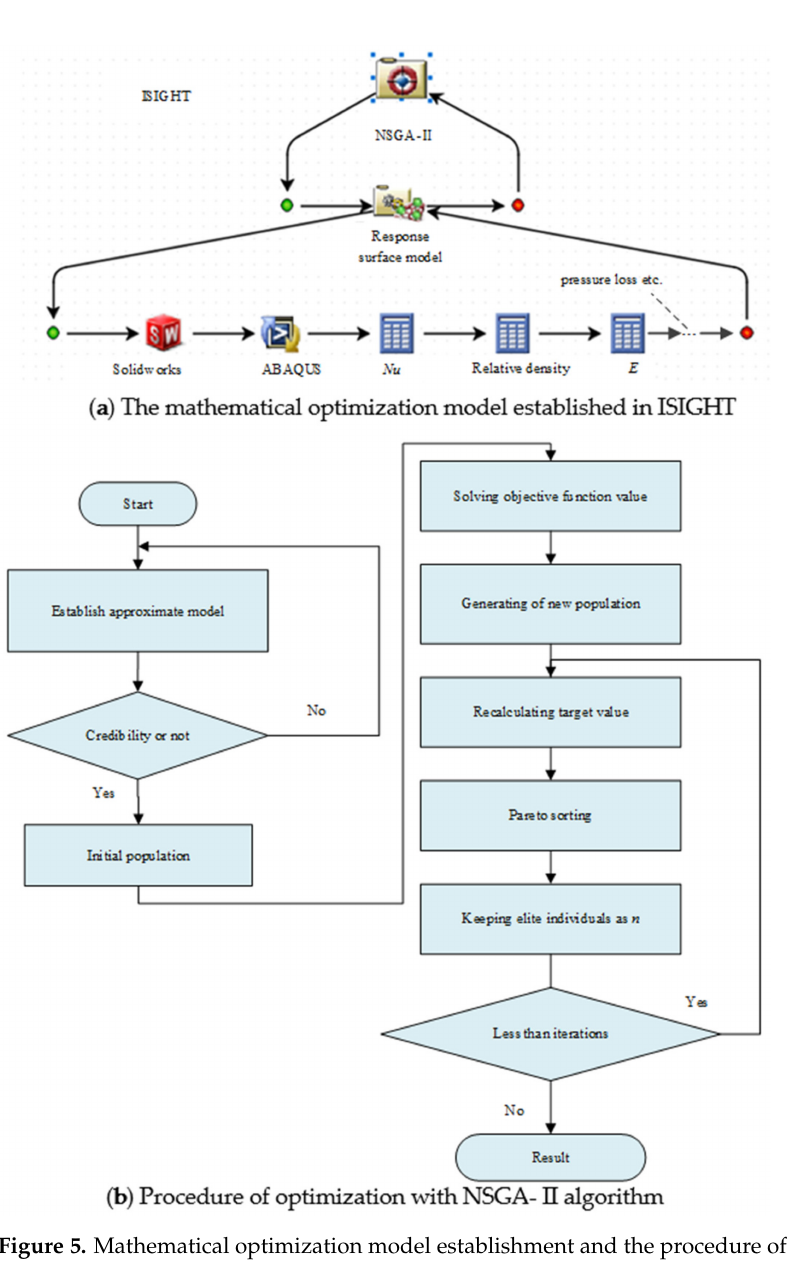
Figure 5. Mathematical optimization model establishment and the procedure of optimization.